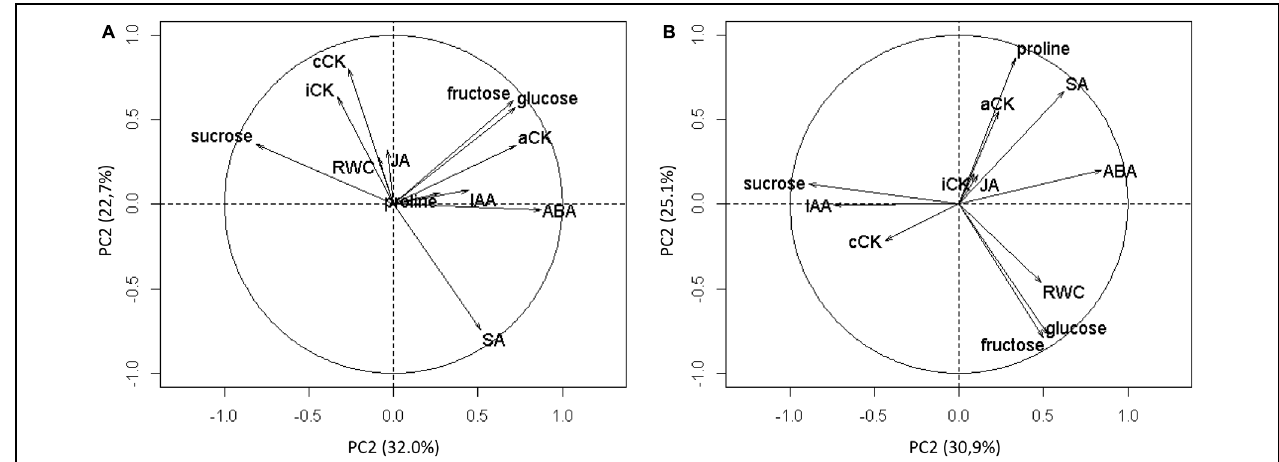
FIGURE 6 | Circles of correlations of the principal components 1 (PC1) and 2 (PC2) of the principal component analysis (PCA) built using 12 physiological variables. The variables were measured during WRP1 and WRP2 periods (A) and during WWP1 and WWP2 periods (B) .